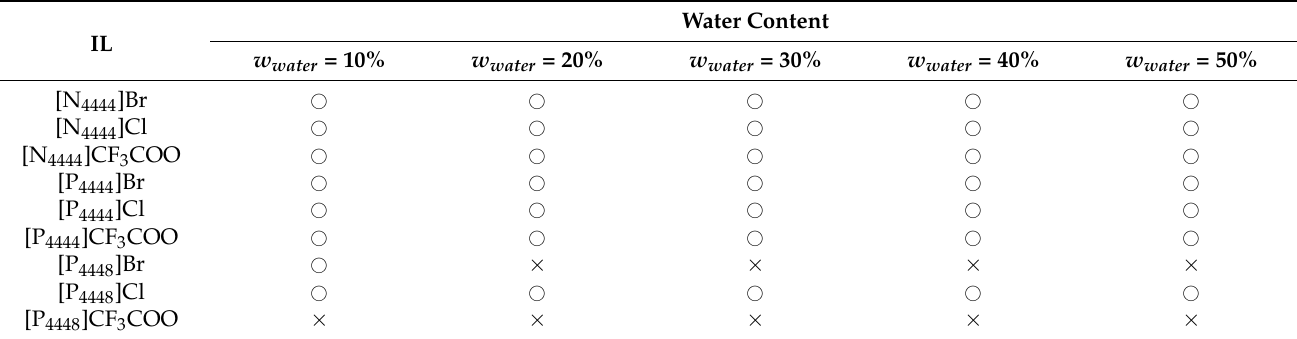
Table 1. Phase behavior of IL–water mixtures at 298.15